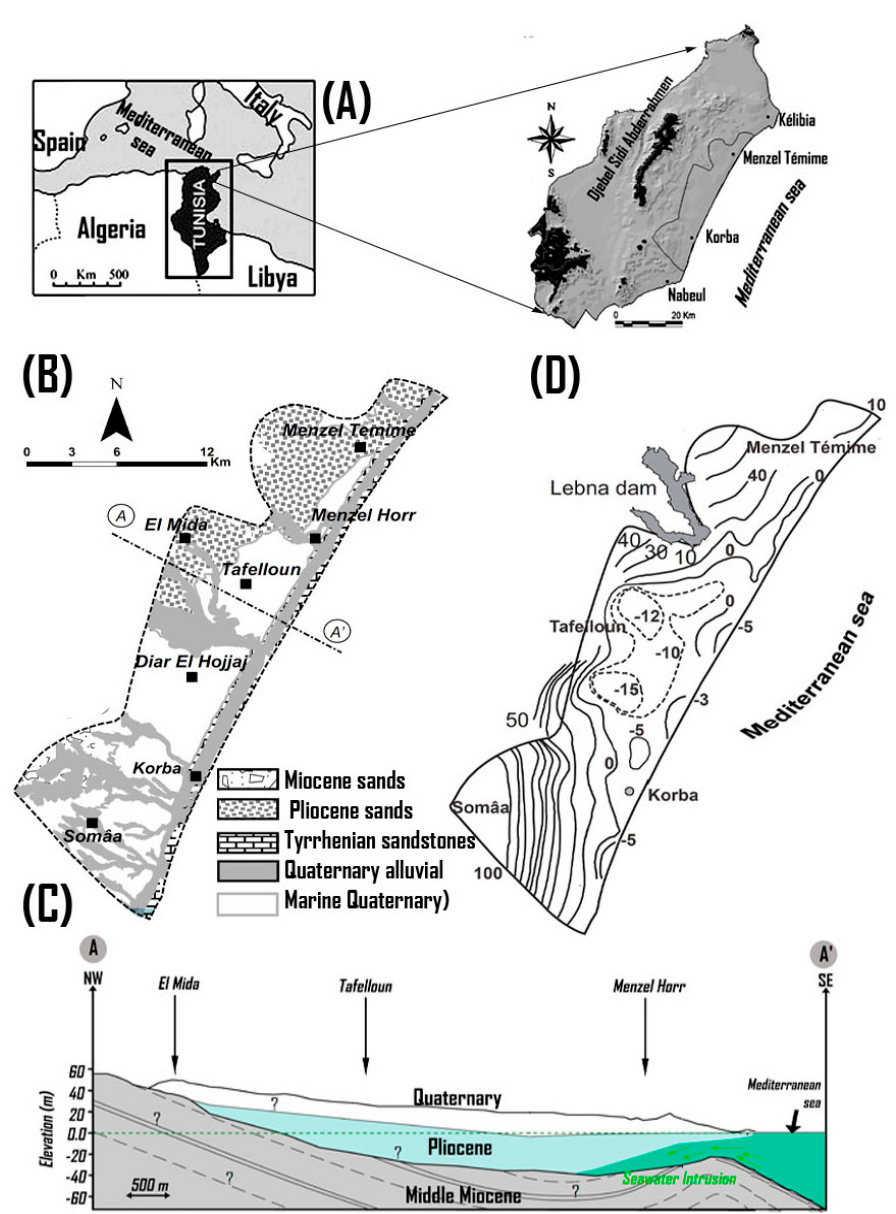
Figure 1. ( A ) Location of Tunisia and Cap − Bon peninsula; ( B ) Geological setting of the study area [41], ( C ) synthetic geological cross − section, and ( D ) piezometric map of the aquifer in 2018 [55]. The Korba region is a predominantly agricultural area (61.9%), and the farmers cul- tivate a wide range of crops including vineyards, citrus fruits, cereals, vegetables, olives, and groves. Agricultural productivity in the area has been ongoing since the early 1960s, increasing from a cultivated area of 89 ha in 1965 [61] to 9200 ha in 2018. The irrigated perimeter is situated between Korba, Diarr El Hojjaj, El Mida, and Menzel Horr. GW pumping represents a significant source of irrigated water in the Korba zone. Extraction of GW for irrigation started in the 1960s with a withdrawal rate of 4 million cubic meters per year (MCM/year). This rate has increased to 72 MCM/year. in 2018, with more than 14,000 active wells